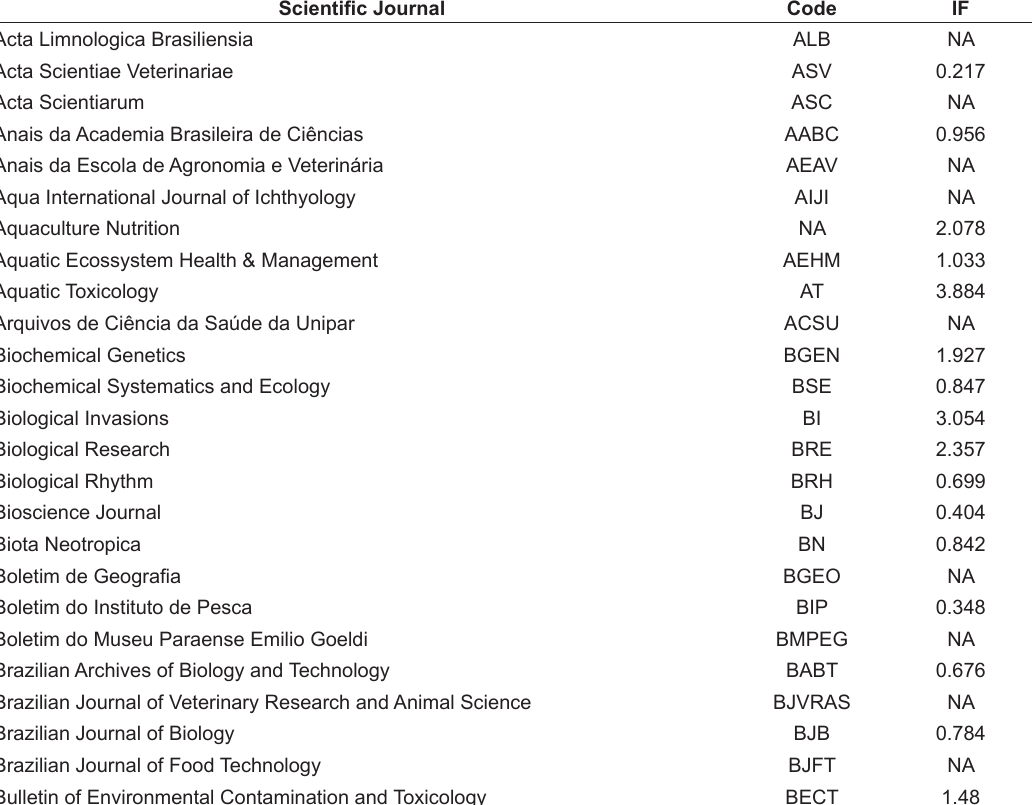
Table 1. List of the scientific journals where freshwater fish papers related to Goiás State were published, their code (Figure 4a) and impact factor (IF, Scijournal.org,